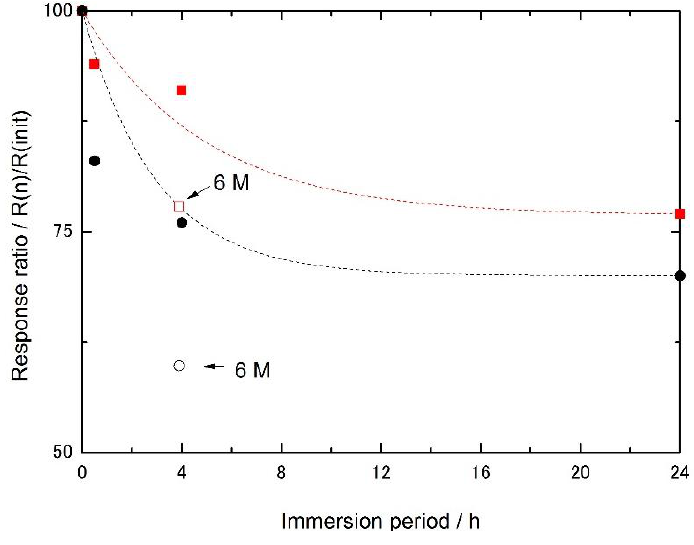
Figure 3. Response ratio to 1 mM glucose before and after immersion of the electrode in 3 M urea. The red squares represent cellulose-based GOD membranes. The black circles represent polyion complex membranes containing GOD. The open marks represent immersion in 6 M